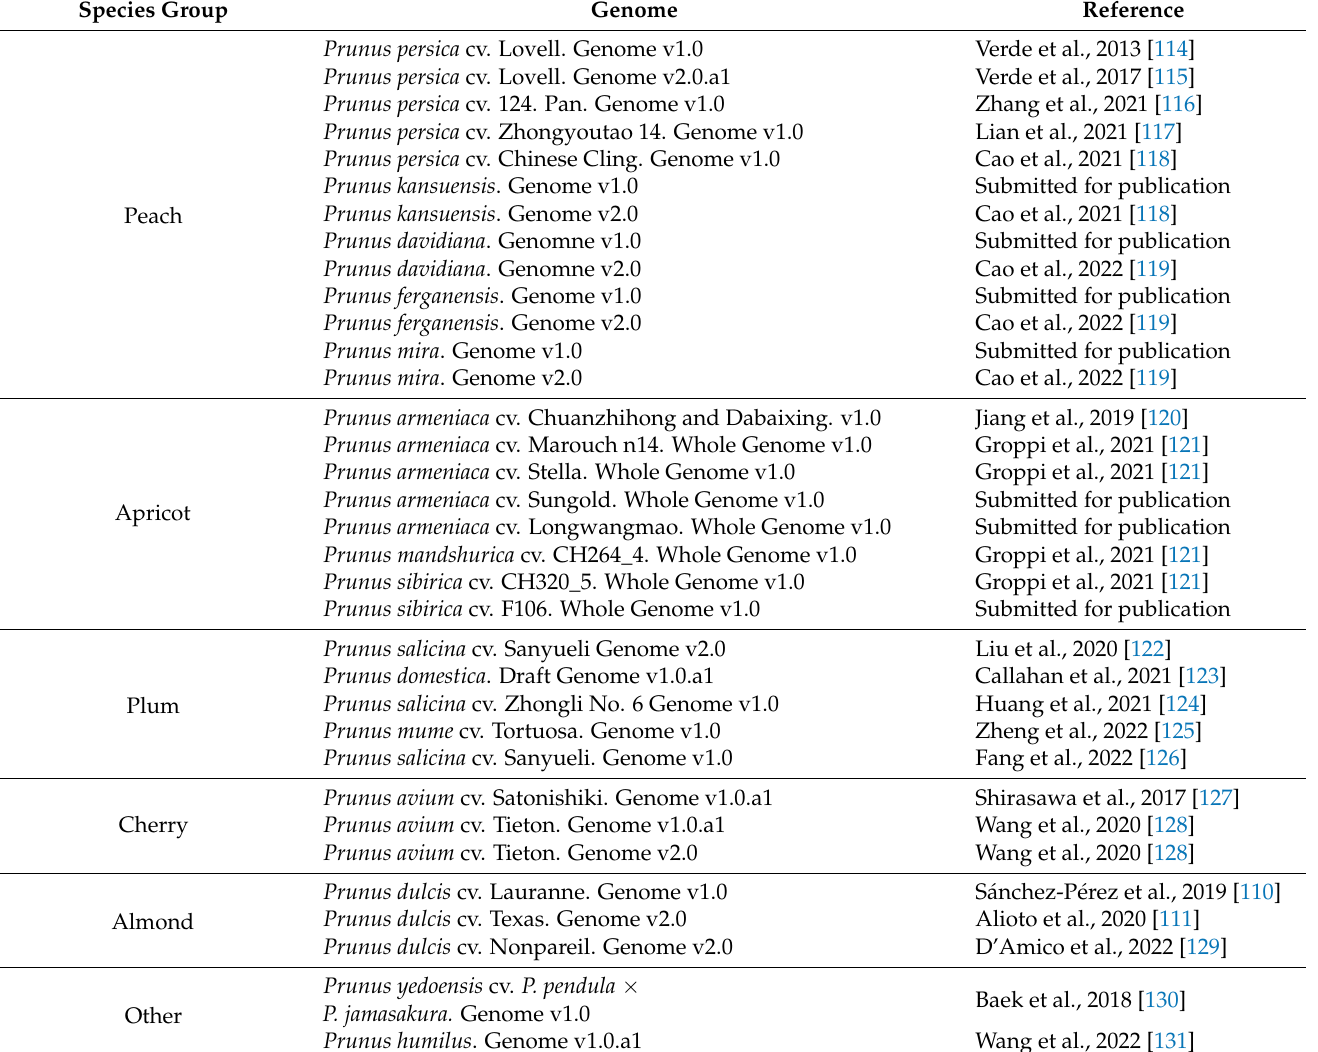
Table 2. Summary of the Prunus Genomes data available in the Genome Database for